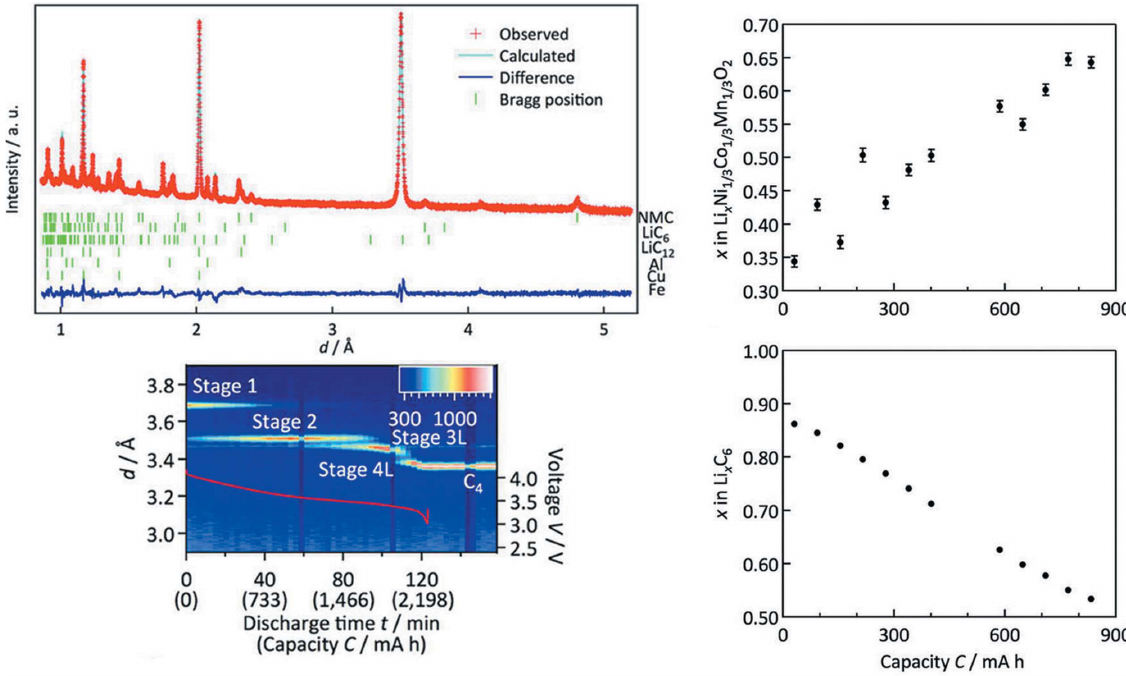
Figure 11 (Left) The high-quality operando neutron powder diffraction data obtained on the SPICA diffractometer, and (right) the results derived from Rietveld refinements detailing lithium content in both electrodes. Adapted from Taminato et al. ,